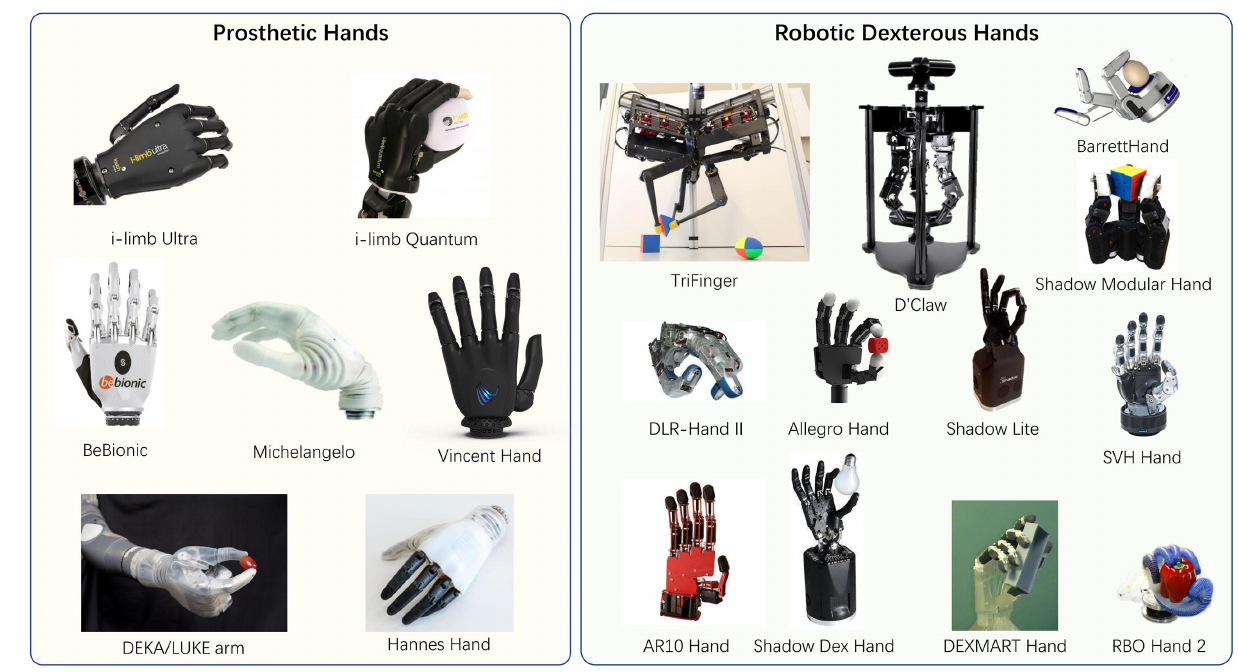
FIGURE 4 | Some of the current designs of dexterous